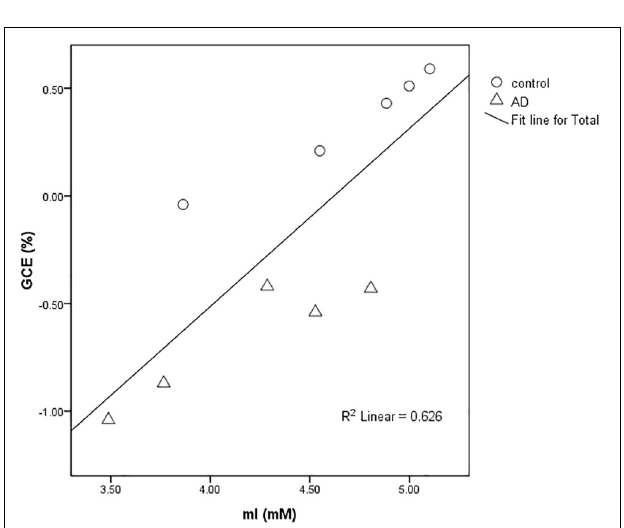
FIGURE 5 | Scatter plot of the relationship between the mean GCE signal of rat total brain and hippocampal MI concentration detected by MRS in the AD group and control group at 28 days after A β 25–35 administration. The graph showed a positive correlation between MI concentration and GCE signal ( R 2 = 0.626).